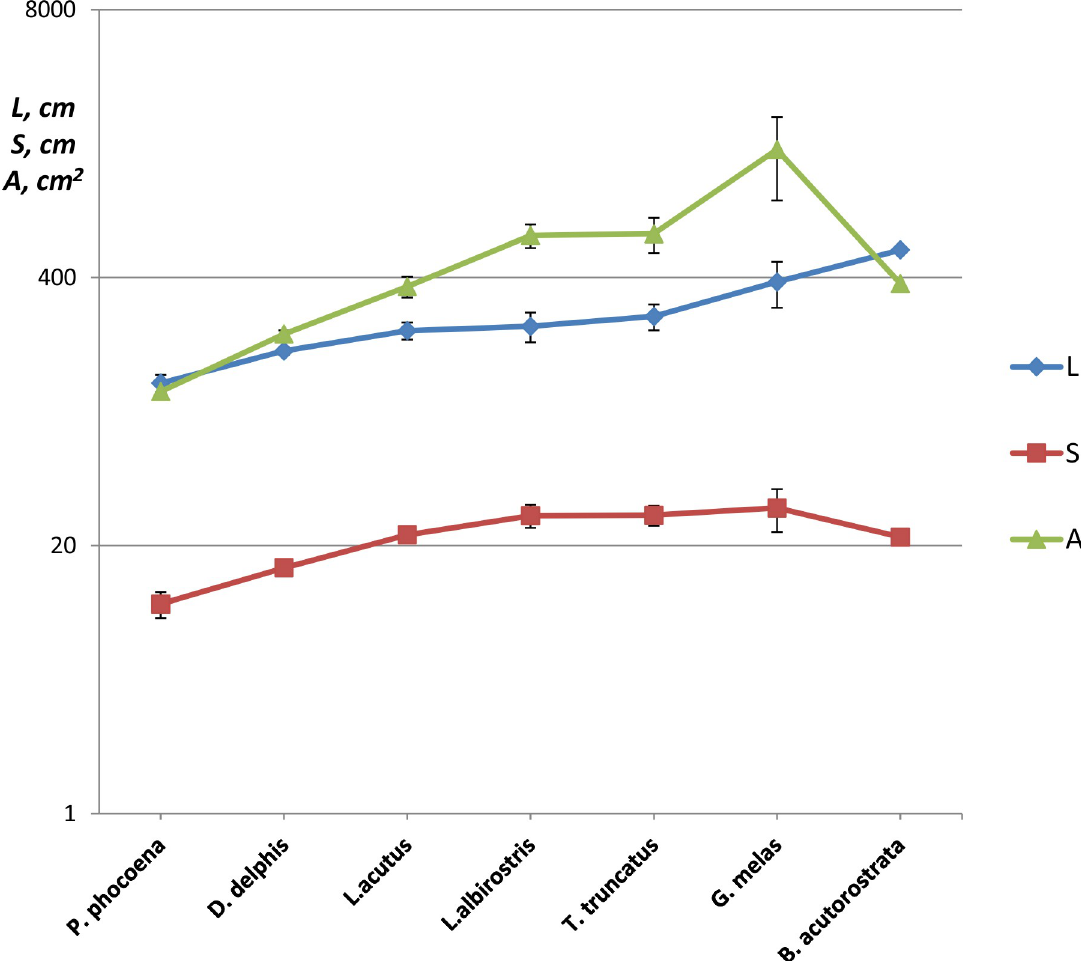
Fig 6. Species-specific differences in the body length L cm, span of the dorsal fin S cm and area of the dorsal fin A cm 2 , means ± SD.